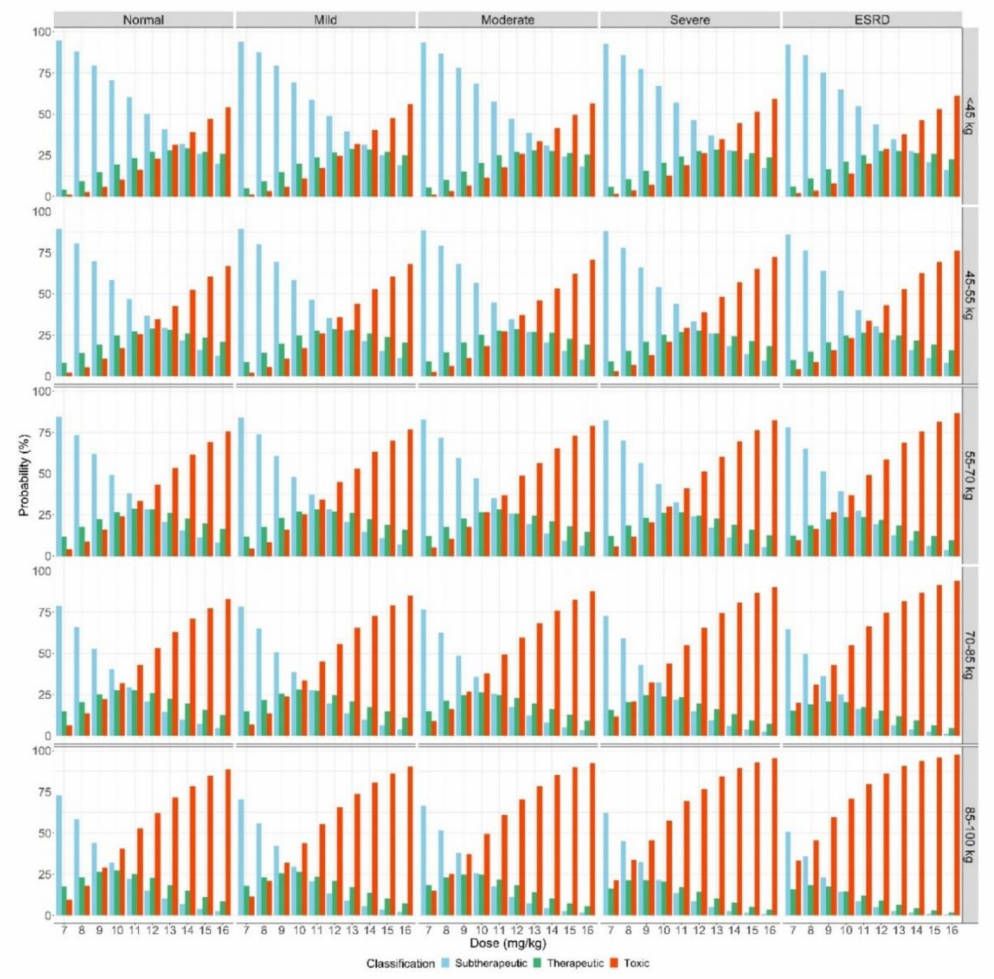
Figure 3. Probability of amikacin therapeutic target attainment from model-based simulations after the following amikacin once-daily dosing regimen on day 5; panel on top of bar plot represents the grade of renal function; Panel on right of bar plot represents the body weight group; Normal, eGFR ≥ 90 mL / min / 1.73 m 2 ; Mild, 60 ≤ eGFR ≤ 89 mL / min / 1.73 m 2 ; Moderate, 30 ≤ eGFR ≤ 59 mL / min / 1.73 m 2 ; Severe, 15 ≤ eGFR ≤ 29 mL / min / 1.73 m 2 ; ESRD, eGFR < 15 mL / min / 1.73 m 2